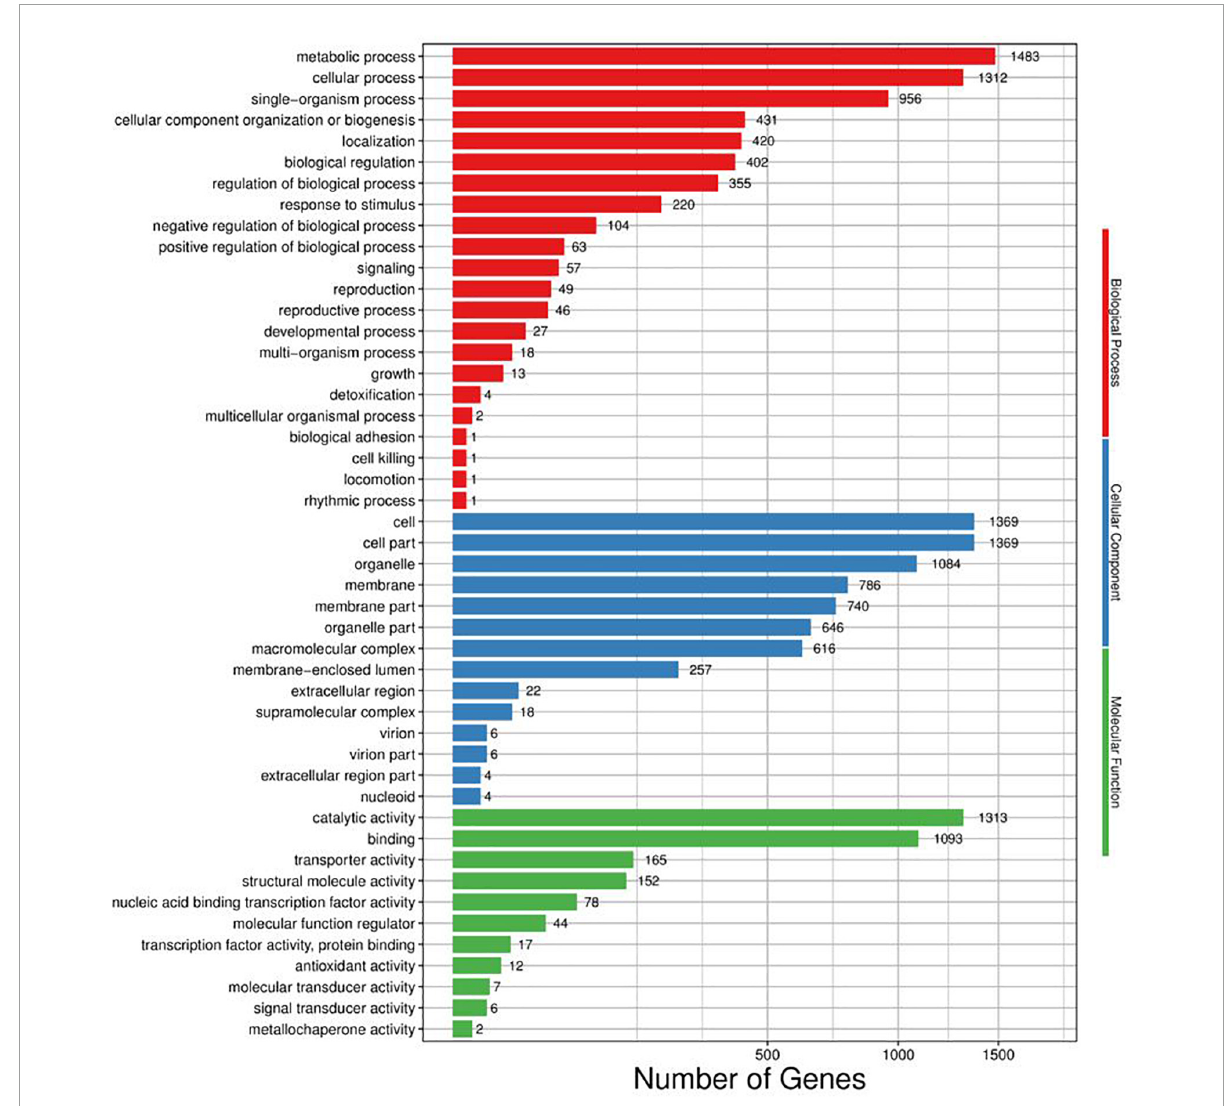
FIGURE4 Distribution of genes differentially regulated in response to ( E )-2-hexenal in the three main categories. The number of DEGs belonging to the most represented categories and the P -values of gene ontology enrichment are shown.